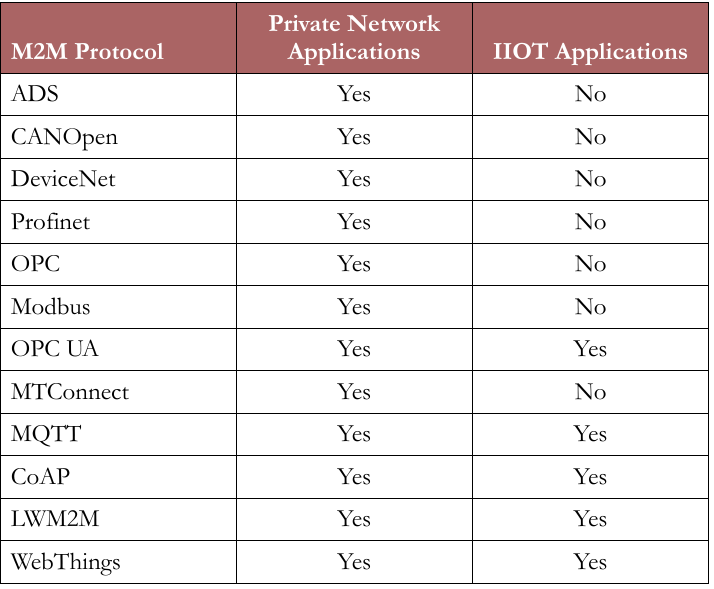
Table 1. Industrial M2M machine